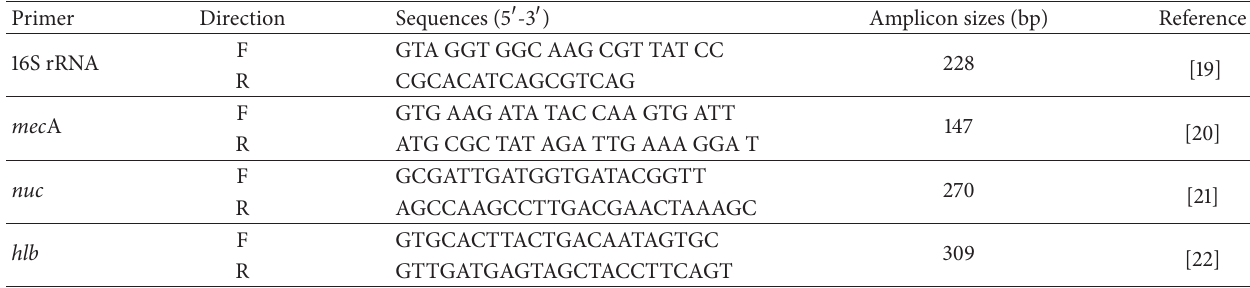
Table 1: Primer sequences of 16S rRNA, mec A, nuc, and hlb genes of Staphylococcus aureus